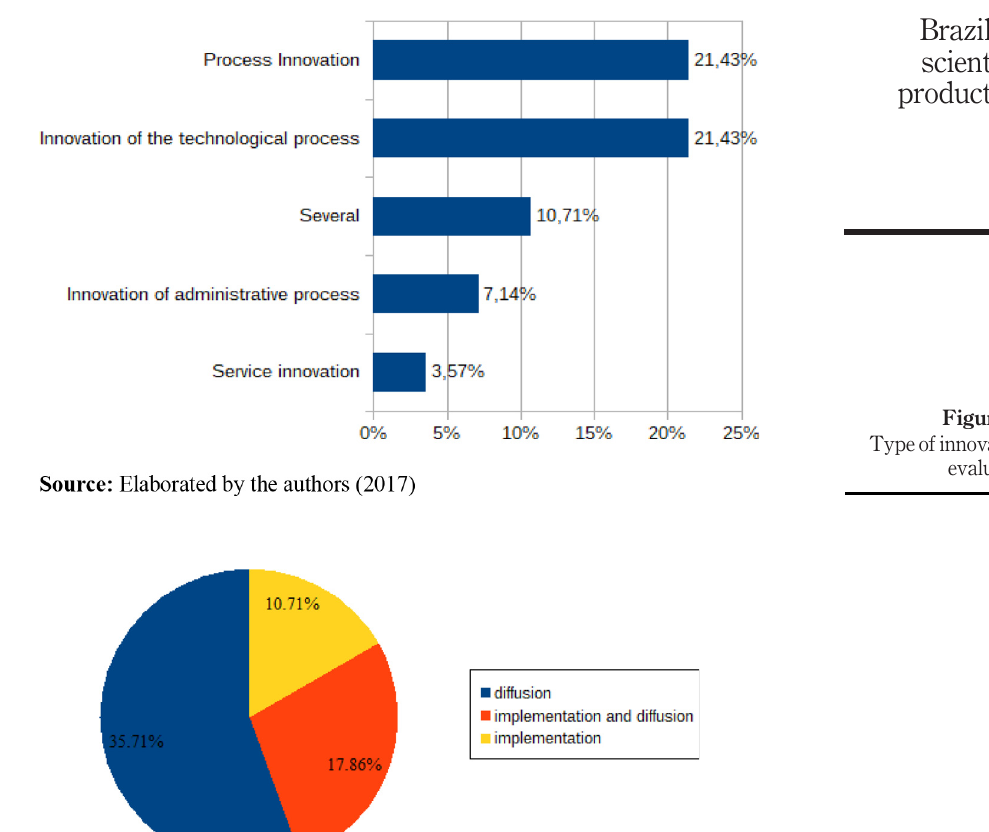
Figure 6. Phase of